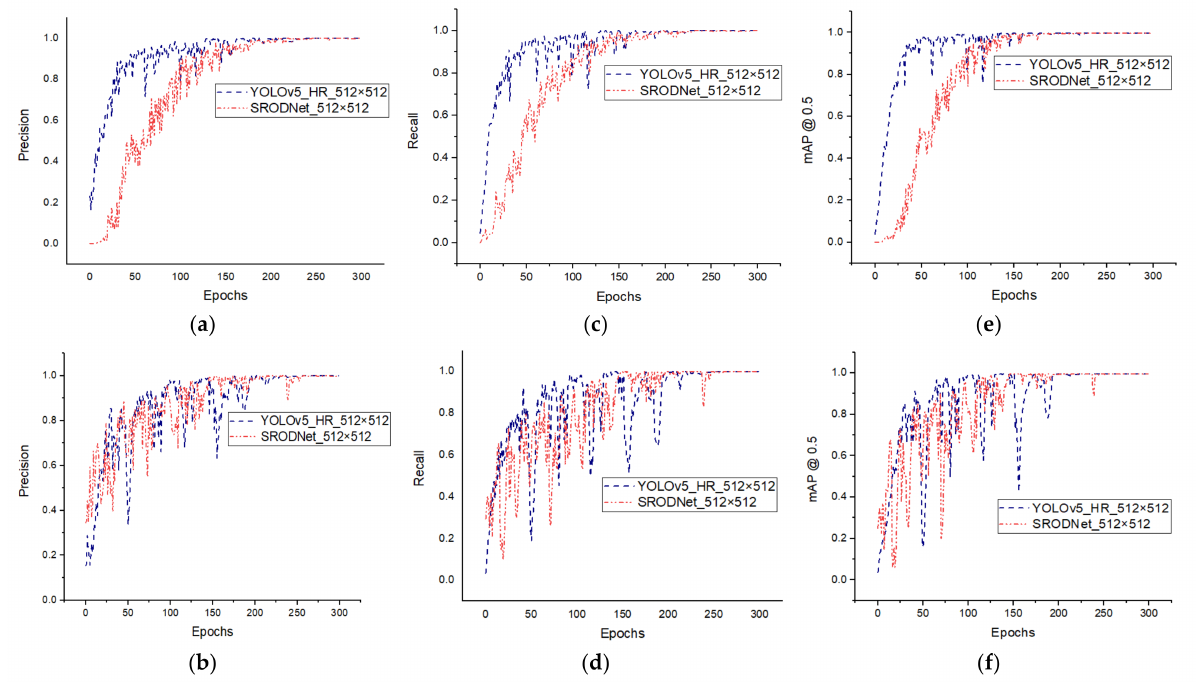
Figure 6. Precision, recall, and mAP @ 0.5 curves on various datasets, such as VEDAI-VISIBLE and